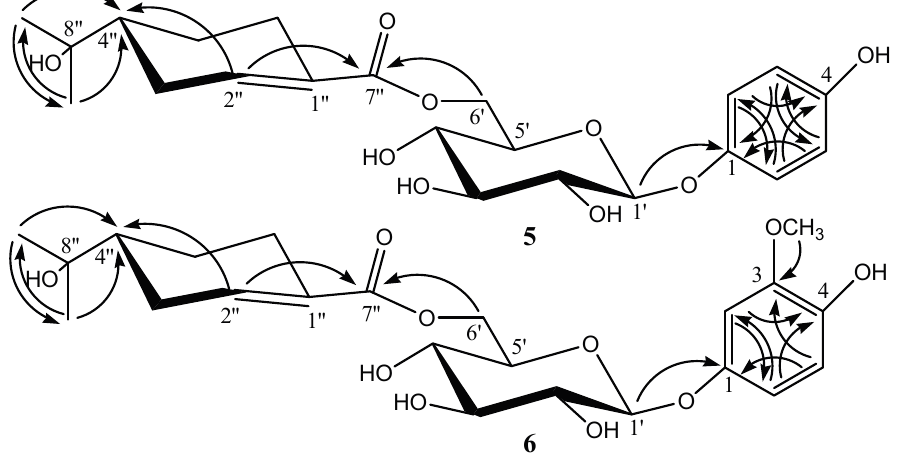
Figure 2. The Key HMBC Correlation of compound 5 and 6 (arrows point from proton to